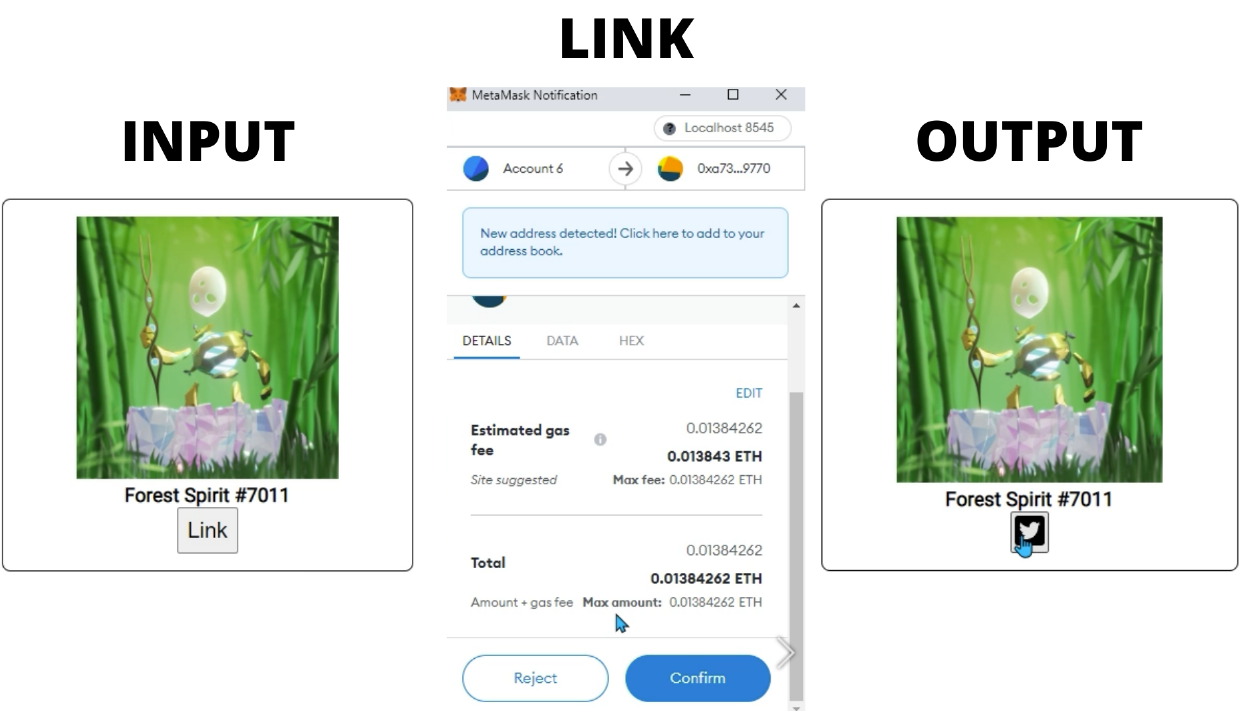
Figure 7. NFT connection to